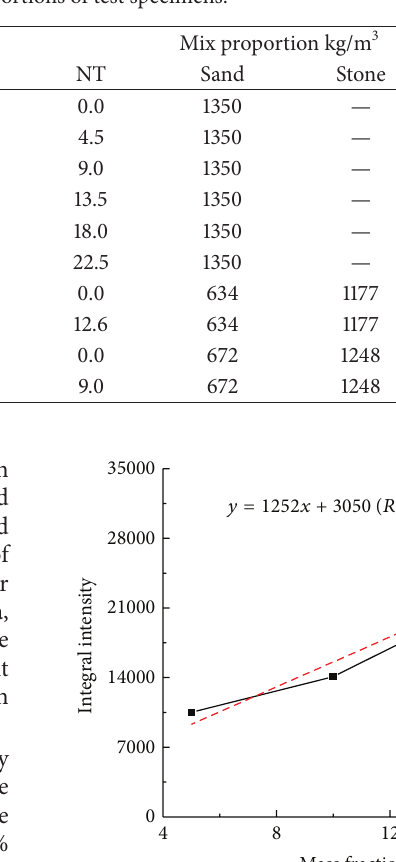
Table 2: Mix proportions of test specimens.